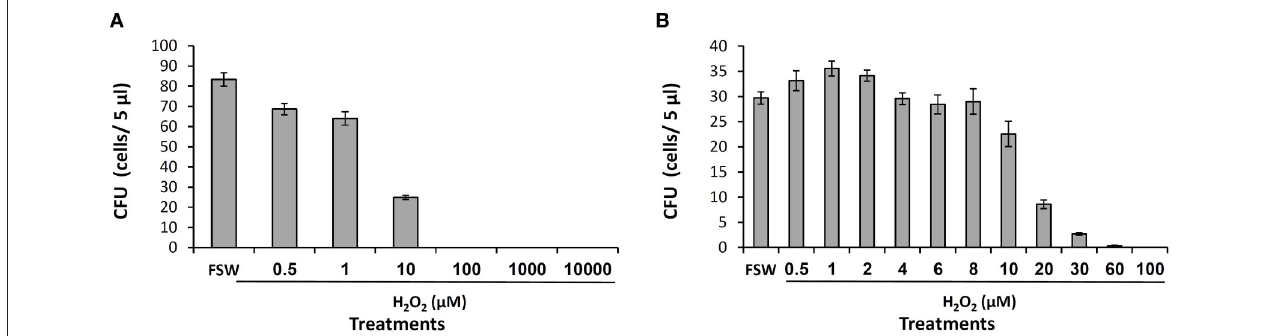
FIGURE 4 | H 2 O 2 toxicity to Vibrio coralliilyticus . The sensitivity of V. coralliilyticus to H 2 O 2 was examined in two independent experiments (A,B) using different H 2 O 2 concentration range. V. coralliilyticus diluted cultures were exposed to H 2 O 2 for 30min and spotted on TCBS agar. CFU refers to the number of colonies appearing on each spot after incubation for 24h at 30 ◦ C.